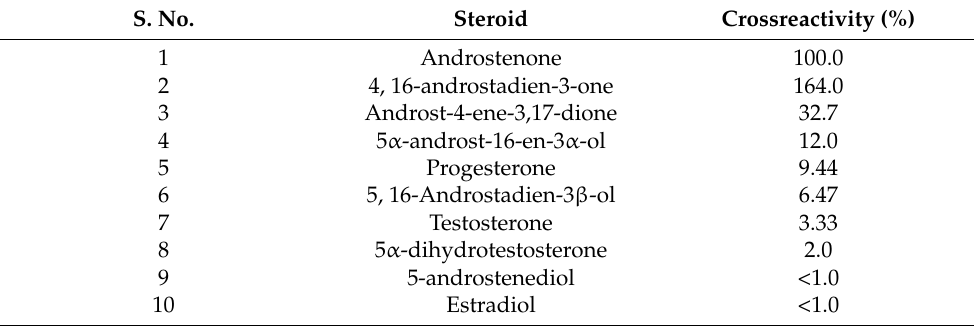
Table 3. Cross-reactivity of Androstenone to other C19 and various steroids. S. No. Steroid Crossreactivity (%) Androstenone